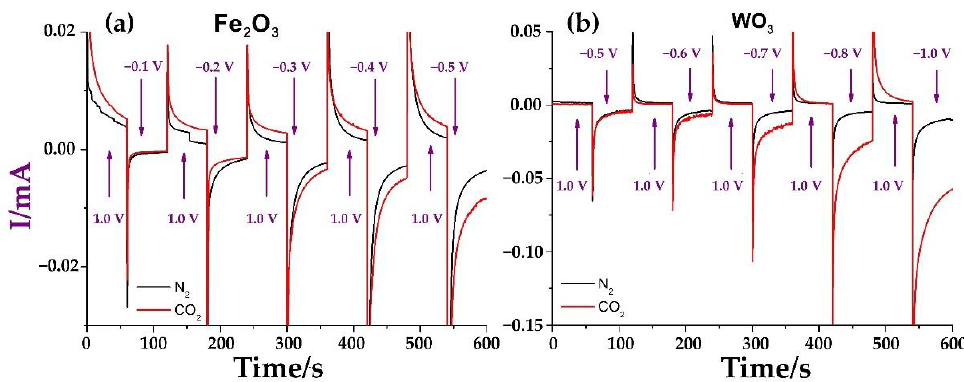
Figure 3. Double potential step chronoamperometry results for the electrocatalytic reduction of CO 2 in 0.1 M TBAF/ACN electrolyte solution with thin-film electrodes: ( a ) Fe 2 O 3 and ( b ) MoO 3 . The red and black graphs correspond to the electrolyte purged with N 2 and CO 2 , individually. Blue arrow corresponds to initial potential (Pi). Arrows indicate potential steps.